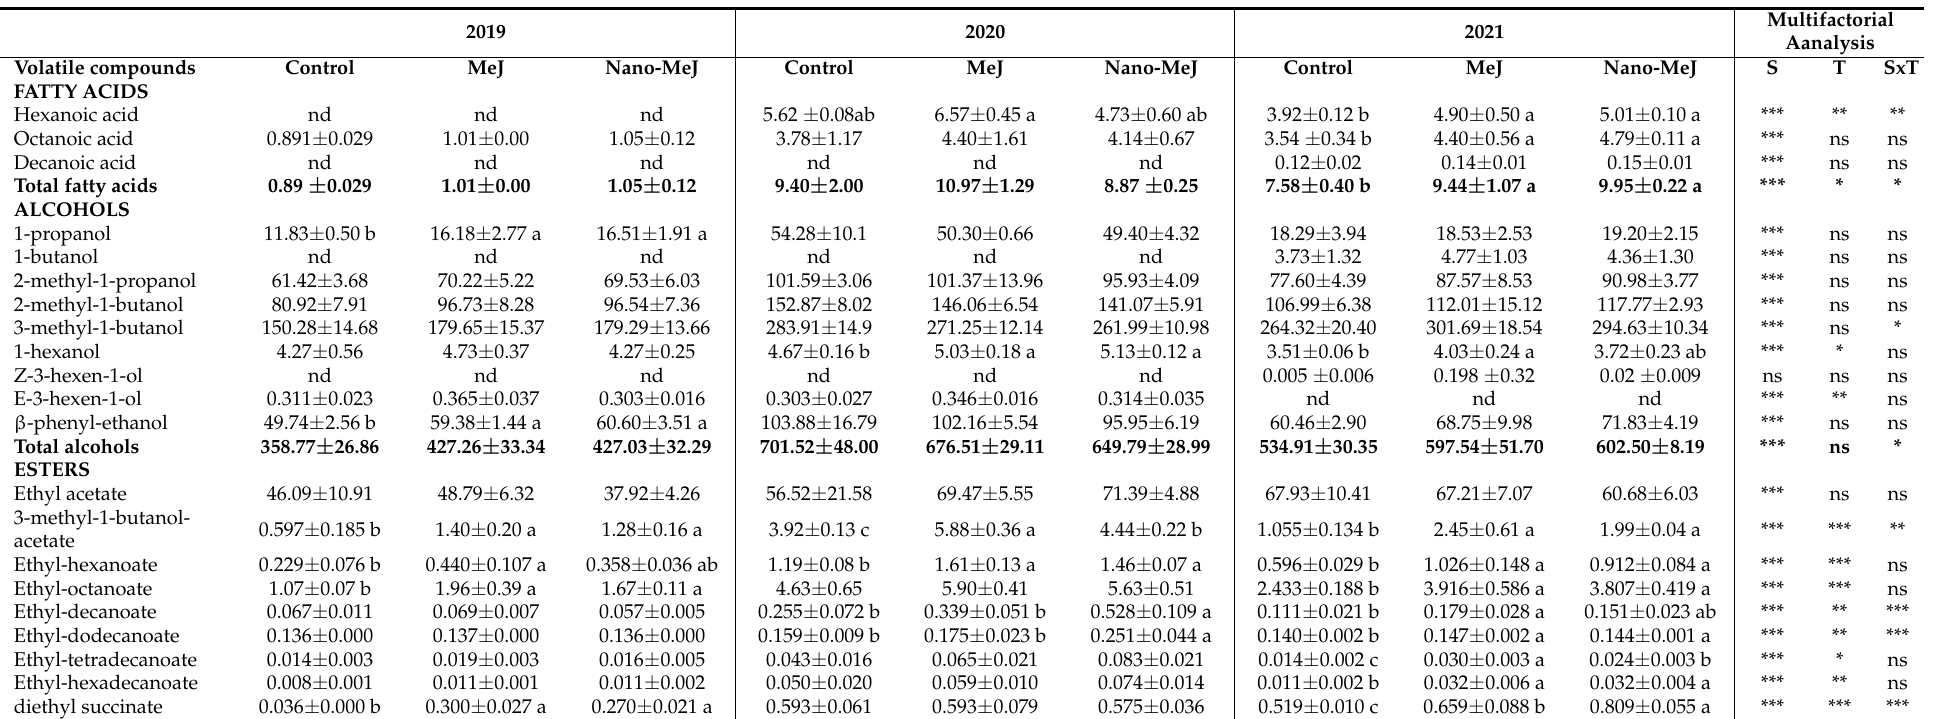
Table 2. Volatile compounds (mg L − 1 ) in Monastrell wines elaborated from untreated grapes (control) and grapes treated with Methyl Jasmonate (MeJ) and Nano Methyl Jasmonate (Nano-MeJ) in 2019, 2020, and 2021